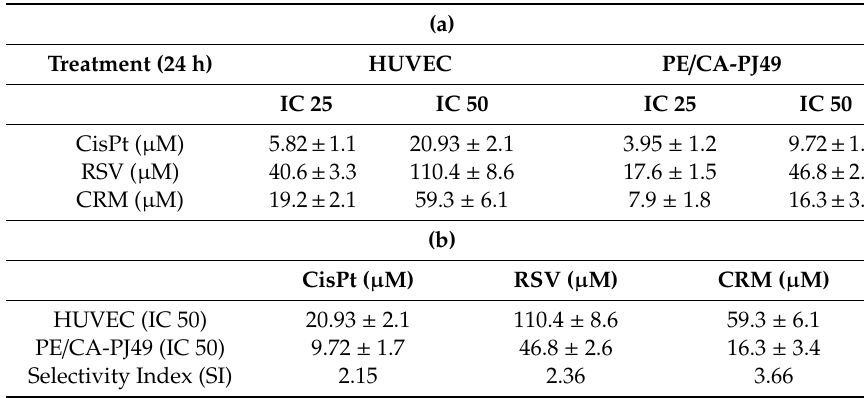
Table 3. Inhibitory concentration (IC 25 and IC 50 ) values of the CisPt, RSV and CRM were performed using a linear regression equation for the cytotoxicity curve for PE / CA-PJ49 tumor cells and for normal cells HUVEC. IC 25 and IC 50 values are presented as mean ± SEM according to two independent assays, each done in triplicate ( a ). The selectivity index (SI), which indicates the cytotoxic selectivity for CisPt, RSV or CRM against cancer cells versus normal cells, and . SI values over 2 were considered as high selectivity ( b